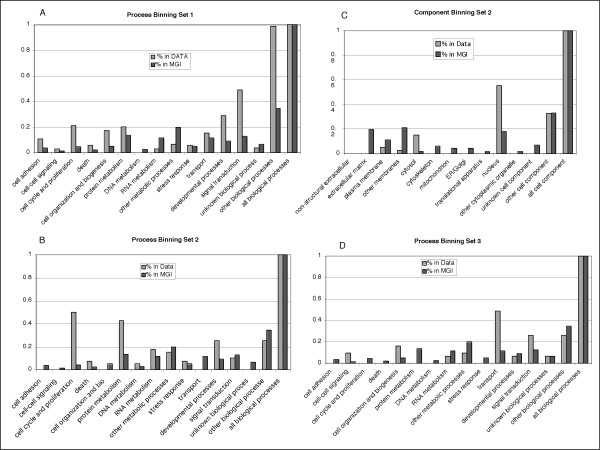
GO_Slim binning, displaying the faction of the total number of genes of either the data set or all genes in MGI falling into the indicated bins. Panel A, process binning for the 109 member set. Panels B and C, process and component for the 40 member set. Panel C, process binning for the 31 member set.